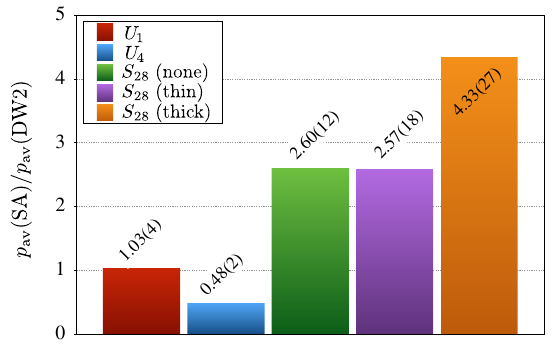
FIG. 4. Ratio between the average success probability for SA and DW2, p SA Þ =p DW 2 Þ , for different disorder classes. In av ð av ð all S 28 cases, SA outperforms DW2 when the number of SA SA Þ =p DW 2 Þ ≈ 1 for the sweeps is tuned such that p av ð av ð bimodal U 1 class. Labels are from left to